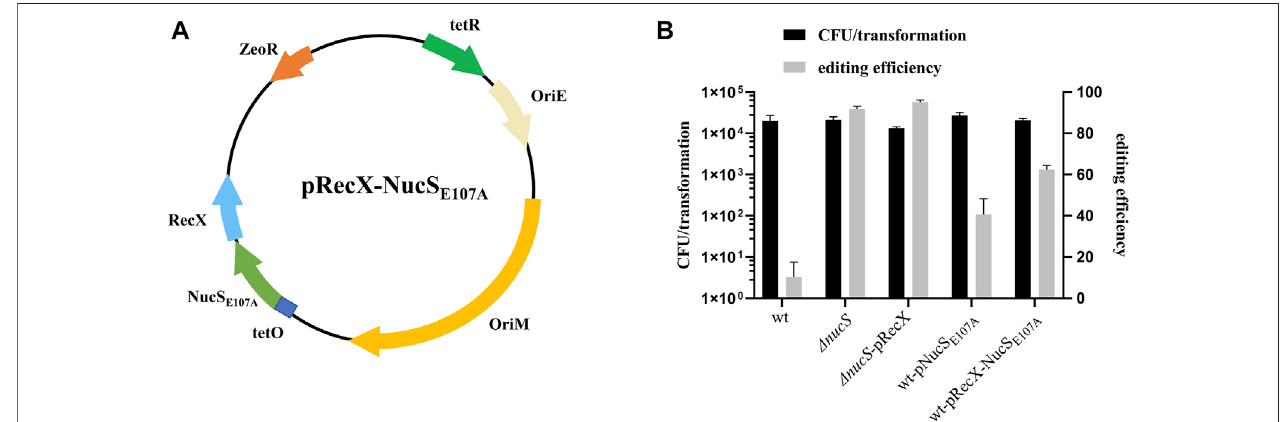
FIGURE 3 | NucS affects the ef fi ciency of single base editing. (A) Map of plasmid pRecX-NucS E107A . The plasmid contains: ZeoR, bleomycin-resistance marker; OriE and OriM; RecX and NucS E107A under the control of the P tetO promoter; and tetR, tetracycline repressor. (B) Deletion of nucS signi fi cantly increased base editing ef fi ciency, and NucS E107A had a dominant-negative effect.